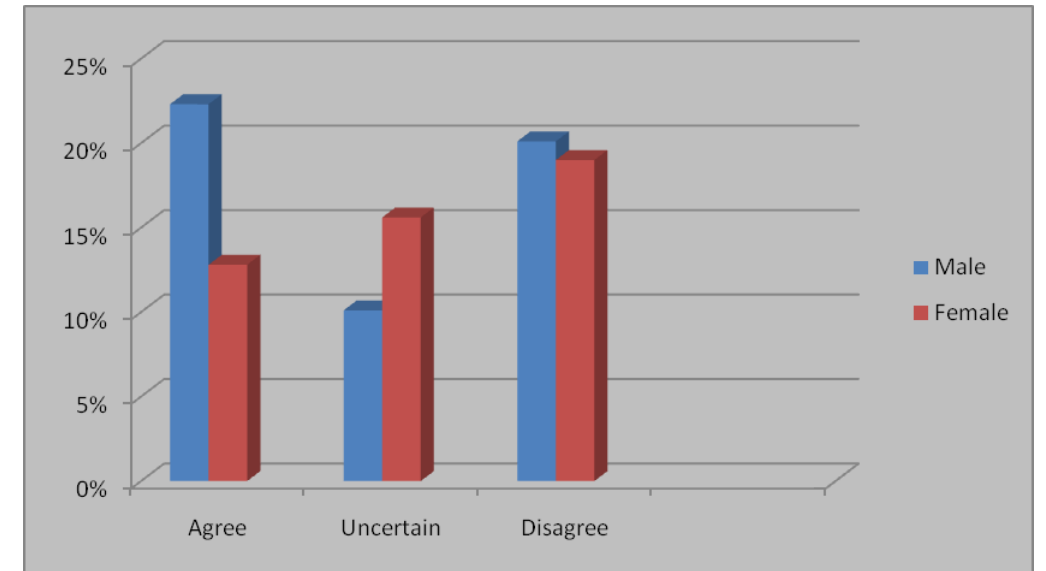
Figure 1: Accessibility of public office information to service users Source: Survey result,